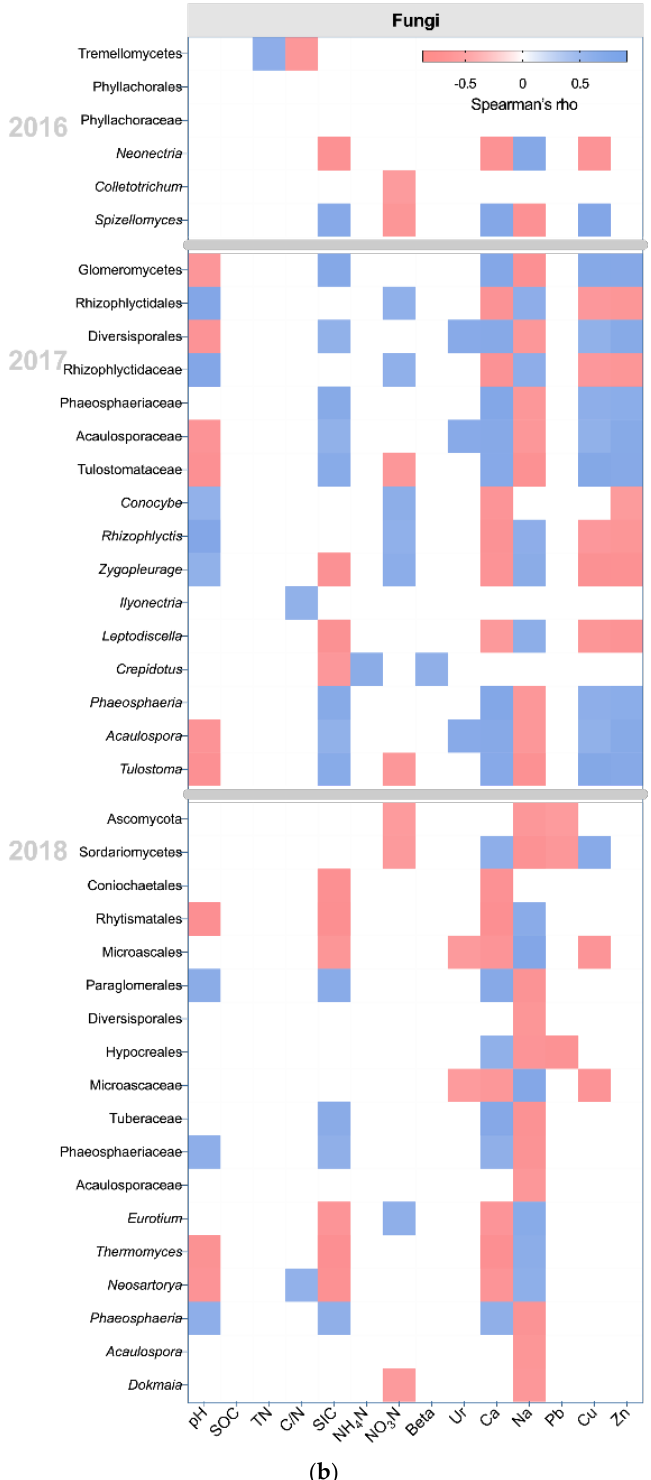
Figure 5. The correlation between edaphic properties and classified microbial communities, based on Spearman’s Rank correlation analysis. Only significant Spearman’s coefficients (rho) are shown (p < 0.05). The blue color represents a positive correlation, and the red color represents a negative correlation. ( a ) The relationships between edaphic properties and classified bacterial communities; ( b ) The relationships between edaphic properties and classified fungal communities.